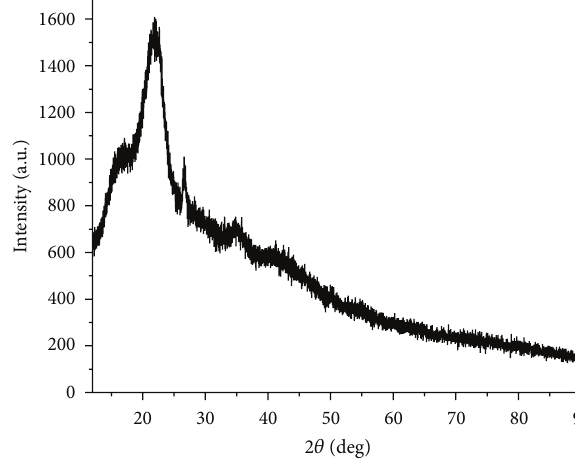
Figure 1: X-ray diffraction of activated carbon derived from maize